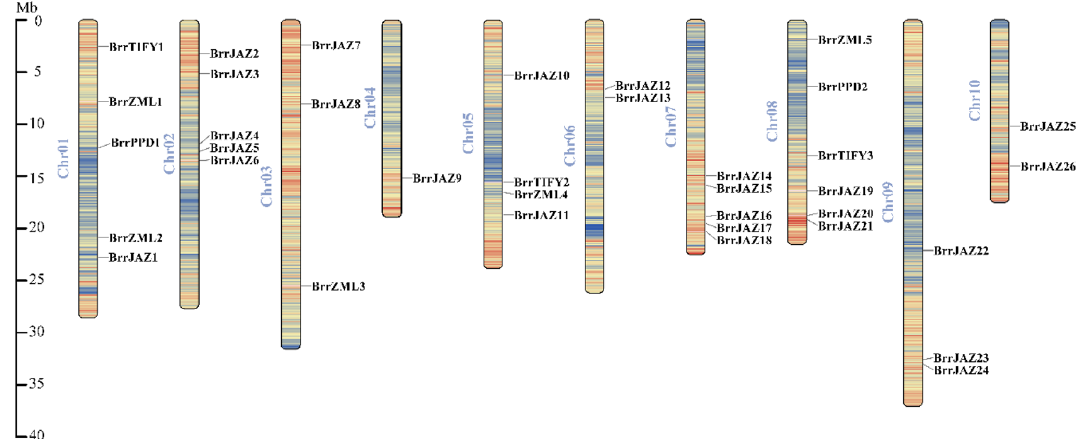
Figure 1. Distribution of BrrJAZ family genes in turnip. A total of 36 BrrJAZ genes were mapped to the 10 chromosomes according to their positions in the turnip genome. The chromosome number was shown on the left of each chromosome.